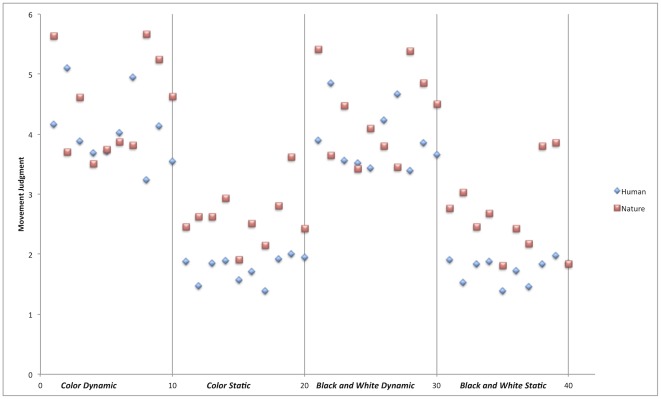
Movement ratings for human and nature images.Scattergram of movement rating for each stimulus.